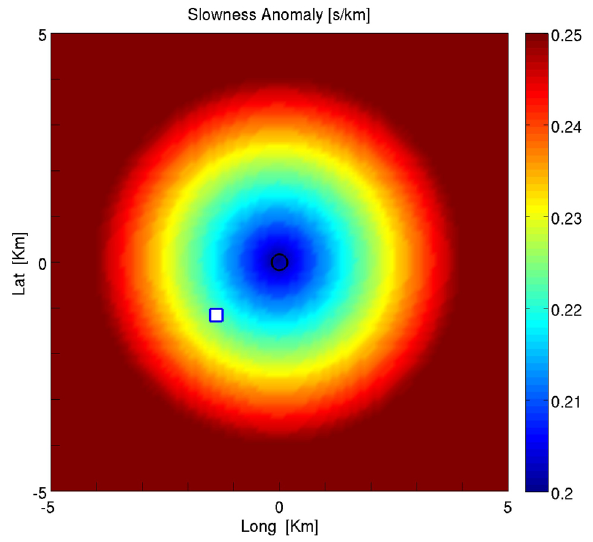
Figure 6. The slowness model used to compute synthetic wave- fronts is characterized by a circularly symmetric anomaly centered at the volcano’s crater (black circle). The blue square represents the array position. The origin of the reference system corresponds to the crater center (40.821,